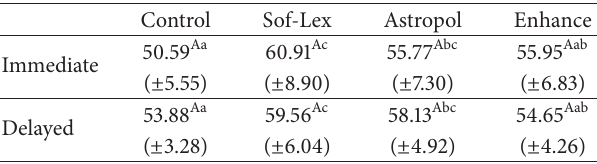
Table 3: Comparison of Vickers microhardness means ( ± standard deviation) for each finishing and polishing systems studied accord- ing to application time.